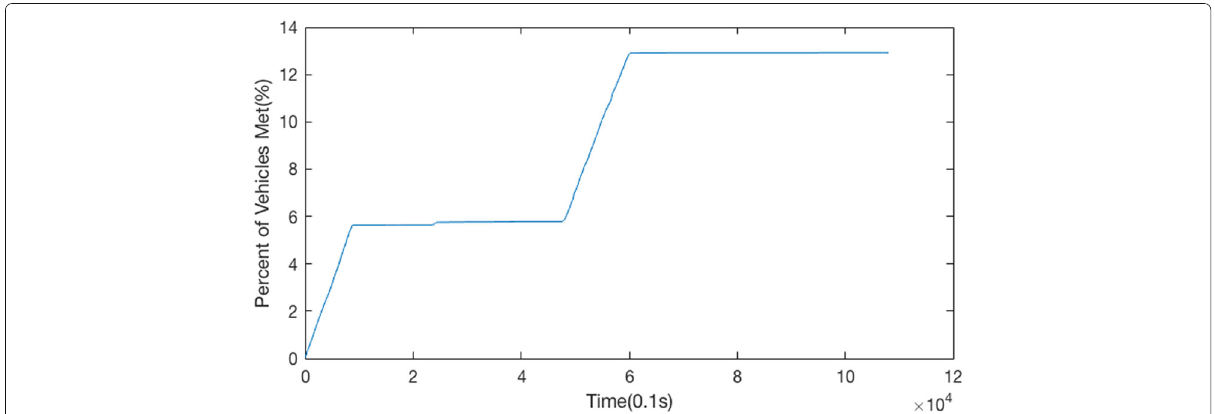
Fig. 2 Time vs. percent of vehicles met